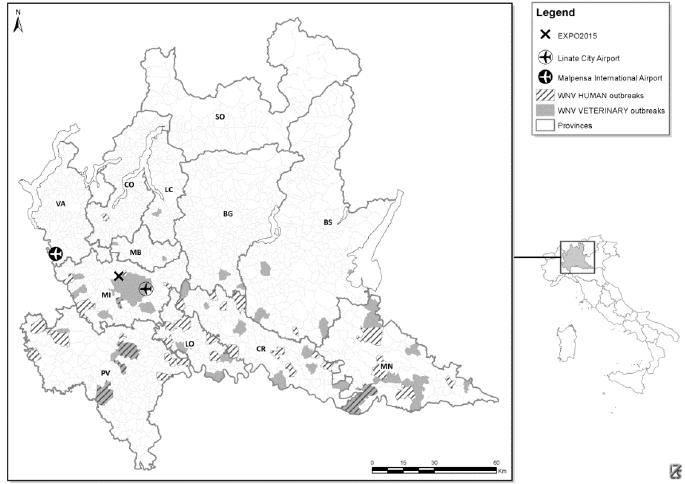
Figure 1. Areas of West Nile virus circulation in 2014 and 2015 in the Lombardy region reporting positive human (clinical case) and veterinarian (vectors, birds and horses) cases during surveillance activities